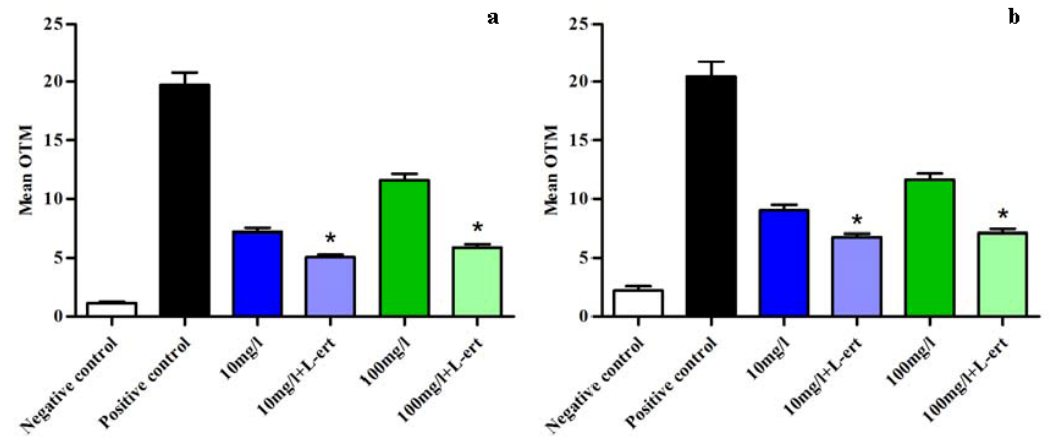
Figure 5. Reduction of DNA damage induced by C adding an anti-oxidant agent ( L -ert = L -ergothioneine) in culture media. ( a ) Follicular cells; ( b ) Mouse ZP+ oocytes. * p ≤